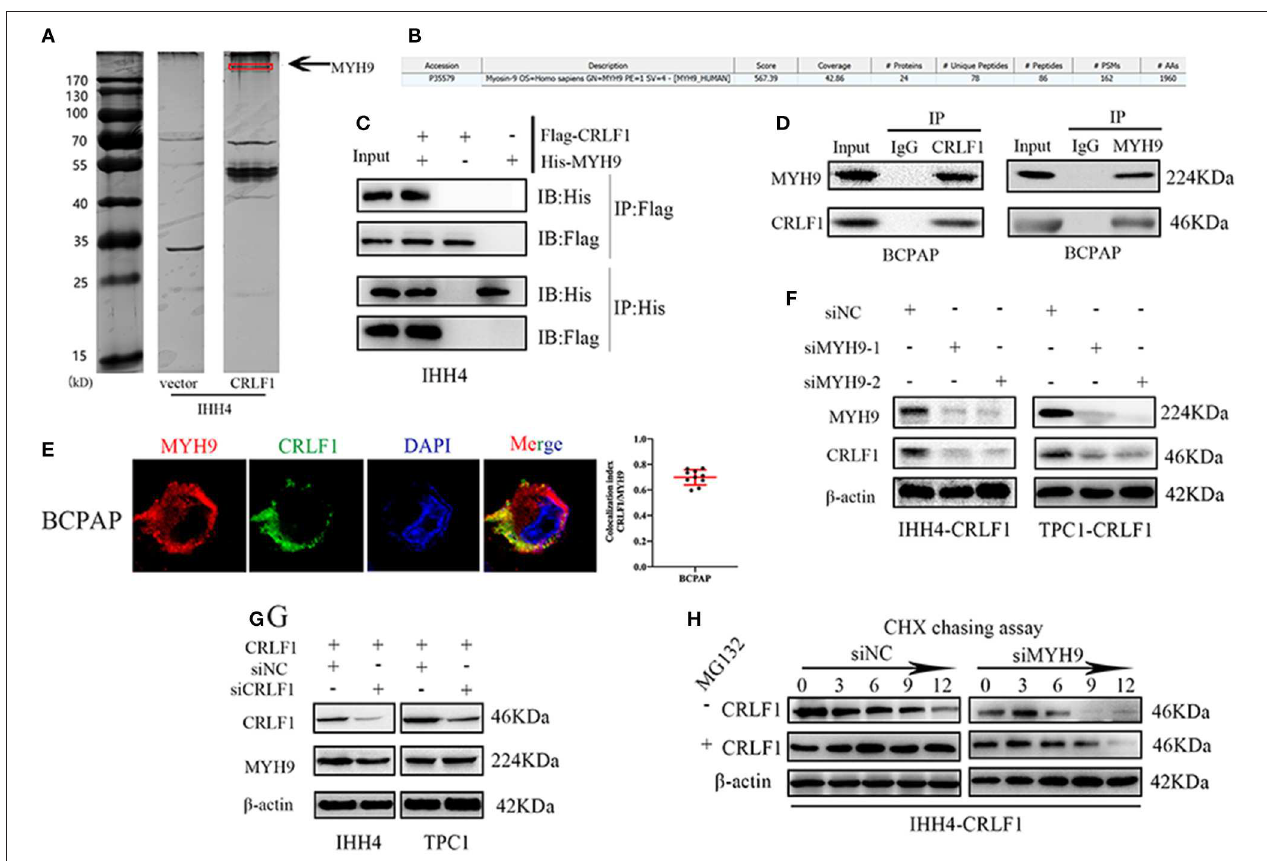
FIGURE 1 | Interaction between CRLF1 and MYH9 in PTC cells. (A) Silver staining showing proteins interacting with CRLF1 in IHH4 cells and the molecular weights of MYH9. (B) Mass spectrometry analysis reveals MYH9 as a potential binding partner of CRLF1. (C) Co-IP showing interaction between exogenous CRLF1 and MYH9 in IHH4 cells. (D) Co-IP experiments reveal the interaction between endogenous CRLF1 and MYH9 in BCPAP cells. (E) Immunofluorescence staining showing the cytosolic colocalization of CRLF1 protein and MYH9 protein in PTC cells. Colocalization analysis was performed in single cells with JACoP plugin in ImageJ. (F) MYH9 and CRLF1 protein expression after MYH9 knockdown by siRNA approach as detected by Western blotting assay. (G) MYH9 and CRLF1 protein expression after CRLF1 overexpression or knockdown as detected by Western blotting assay. (H) Western blot results showing the effect of MYH9 knockdown on CRLF1 expression in PTC cells treated with cycloheximide at different time points and in the presence of MG132. β -Actin served as the loading